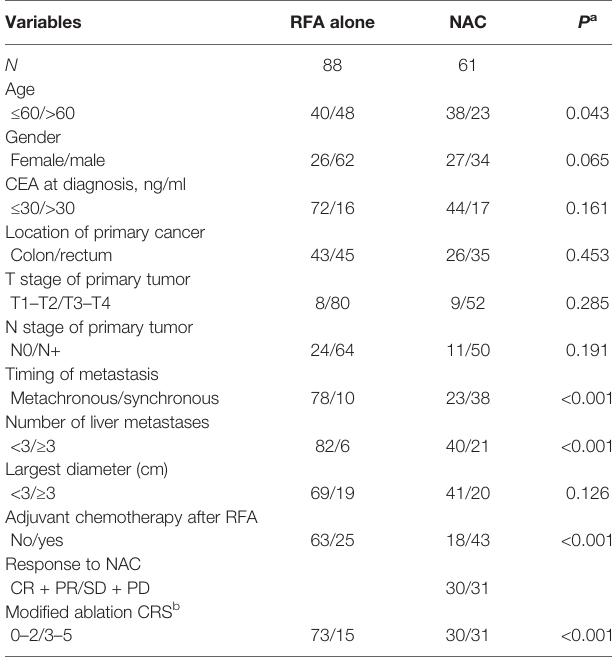
TABLE 1 | Baseline characteristics of the